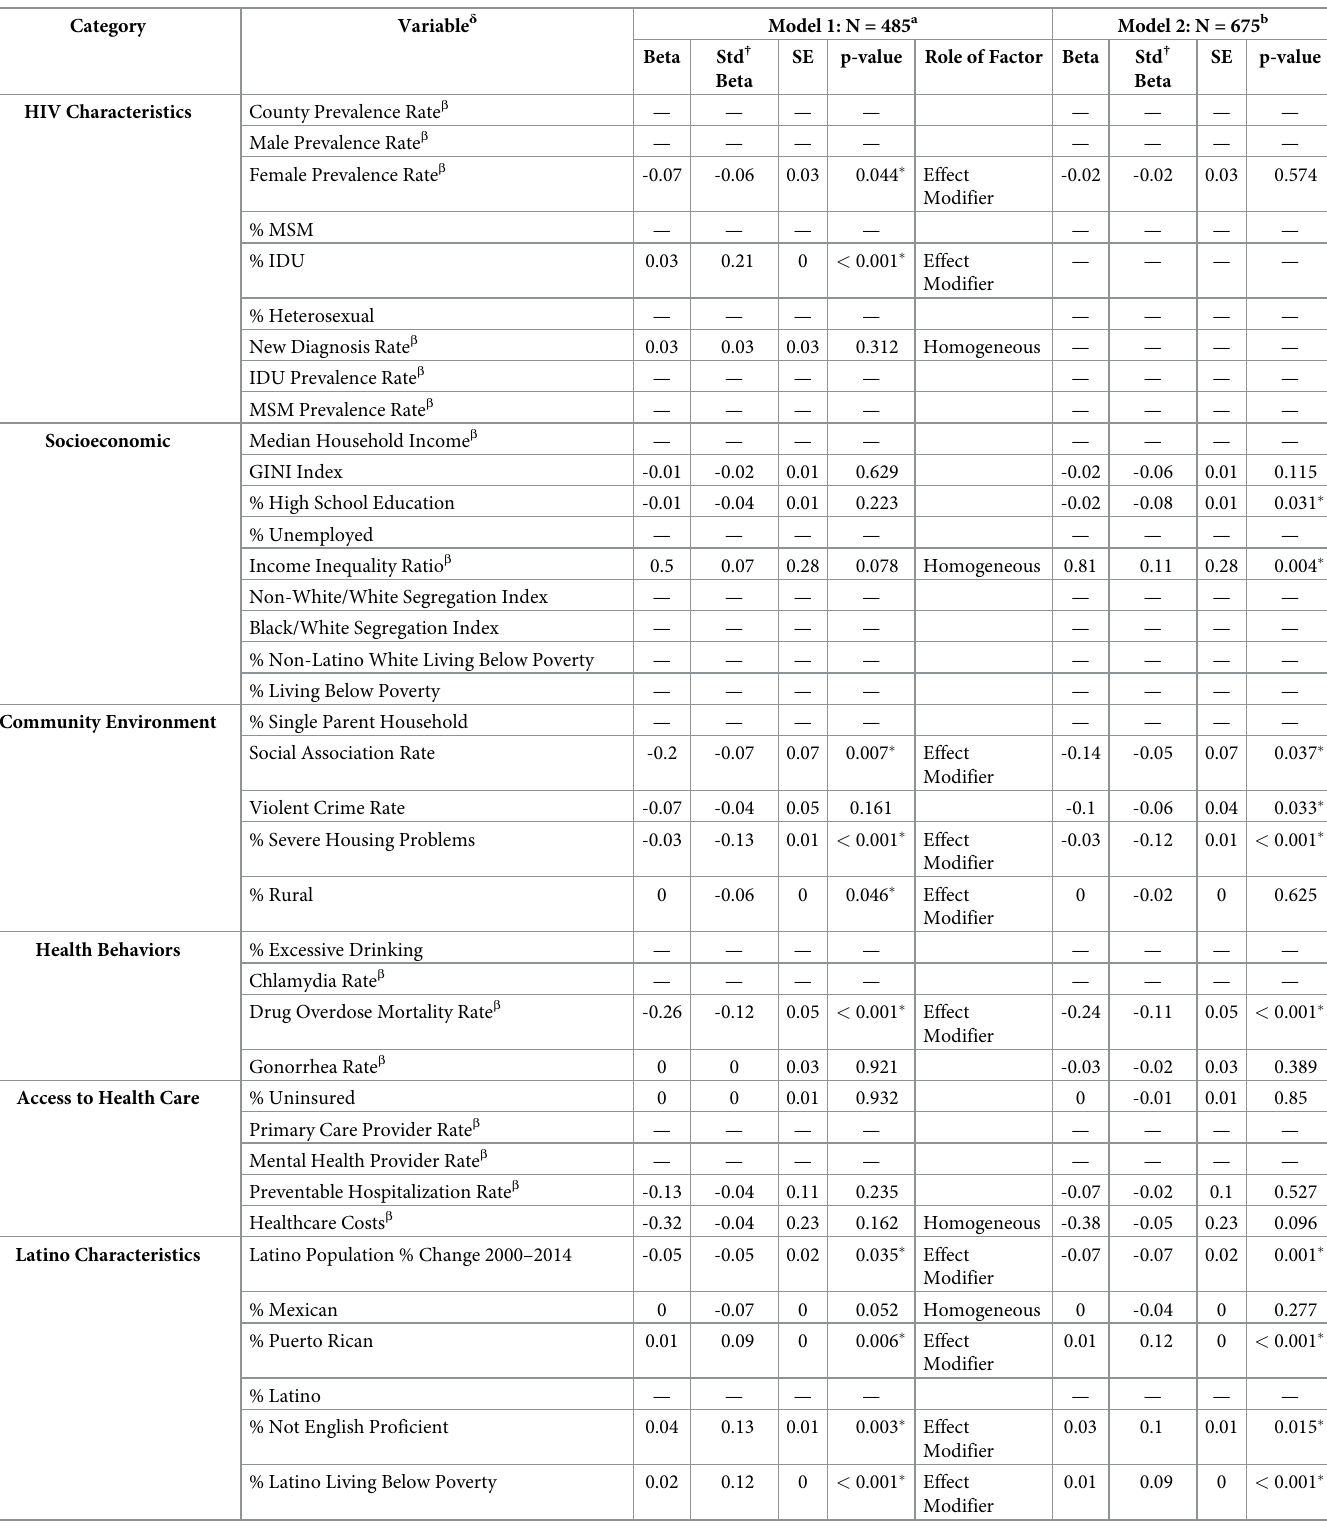
Table 2. A multivariate analysis of county level interactions involving Latino disparity. Category